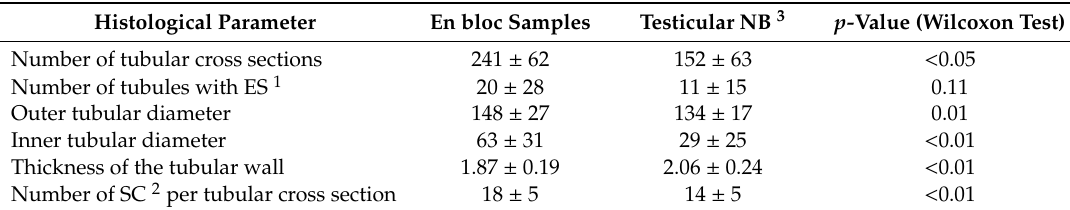
Table 3. Comparison of the mean values of the histological parameters of the en bloc samples (n = 192, proximal, middle distal) and the needle biopsy (n = 32) ± SD measured in HE staining.